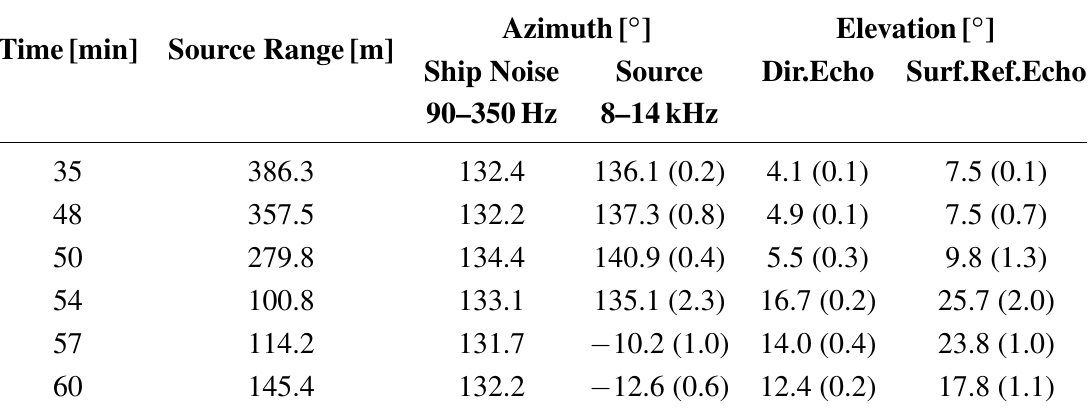
Table 3. Mean azimuth and elevation estimates obtained at various instants of the Makai’05 field calibration event for the ship noise (azimuth only) and for the broadband sound source at 10 m depth and a range between 100 and 400 m (estimated from acoustic data, Figure 10). The values in brackets represent the estimated standard